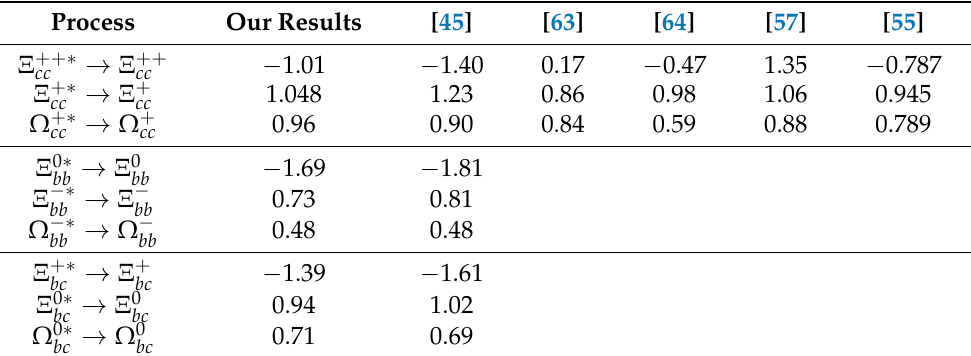
Table 6. Transision Magnetic Moments of doubly charm, doubly bottom and doubly charm-bottom baryons (in units of µ N